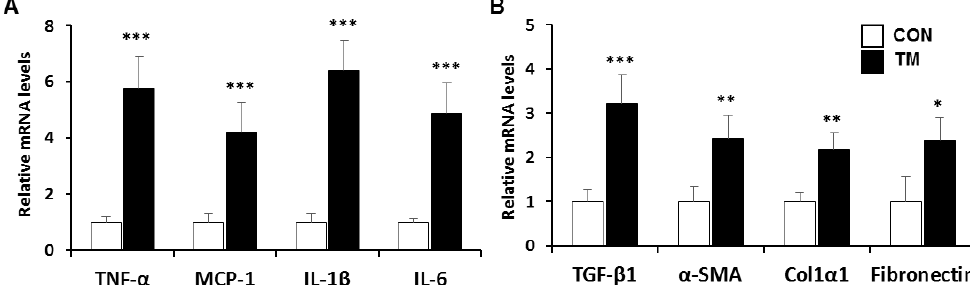
Figure 2. mRNA expression associated with ( A ) inflammatory response and ( B ) fibrogenesis in the liver of TM-treated mice. Each value represents the mean ± SD. *, **, and *** Statistically significant difference between control (white) and TM-treated mice (black) at p < 0.05, < 0.01, and < 0.001, respectively (Student’s t -test).